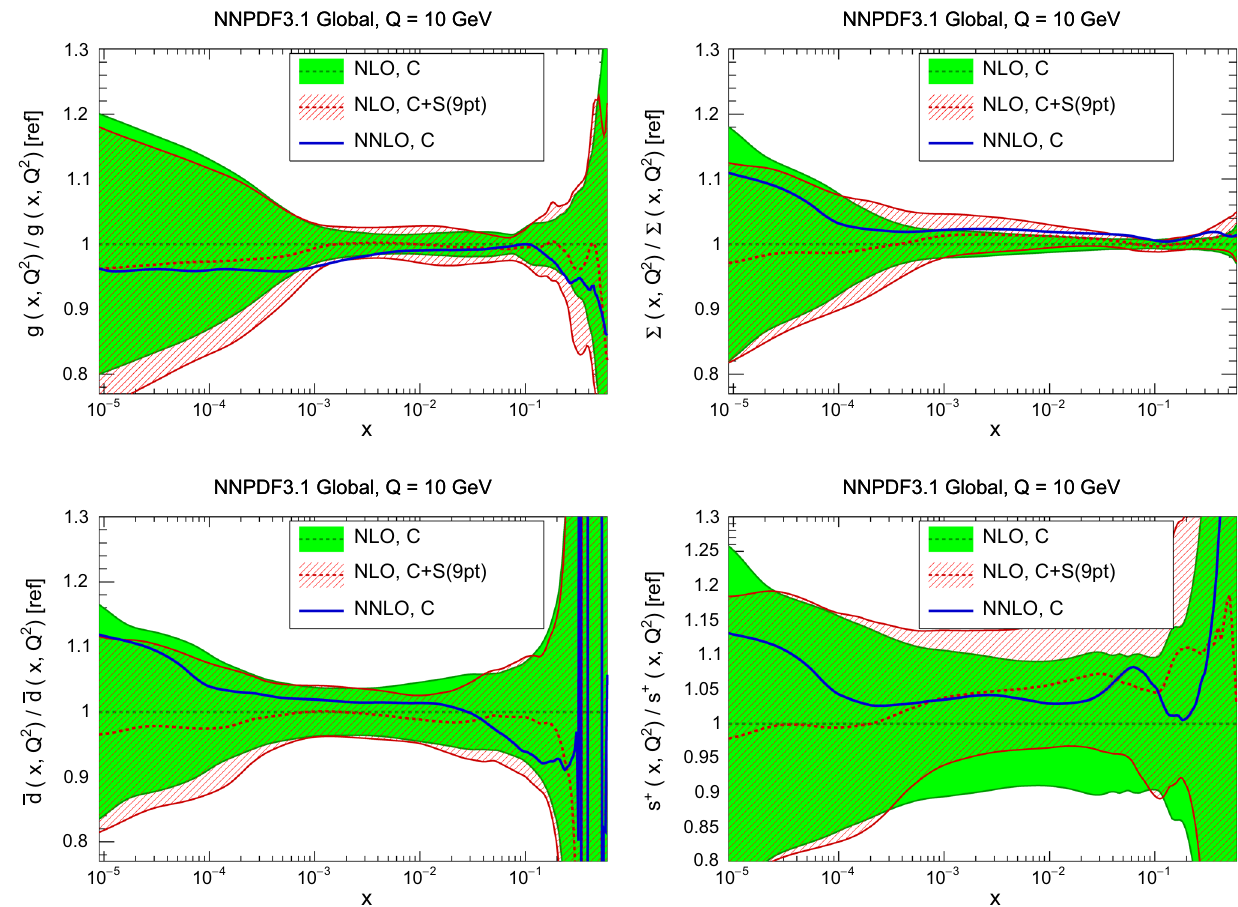
Fig. 16 Same as Fig. 15 now for the NNPDF3.1 global fits. We show the results of the NLO fits based on C and C + S ( 9pt ) normalized to the former, as well as the central value of the NNLO fit based on C . for the gluon, the total quark singlet, the anti-down quark, and the total strangeness PDFs, all at Q = 10 GeV